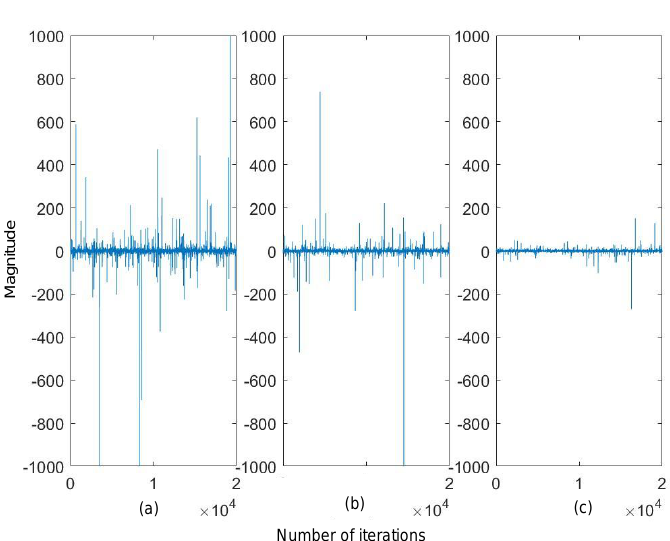
Figure 5. Reference signal of ( a ) α = 1.2, ( b ) α = 1.4, and ( c ) α = 1.6.